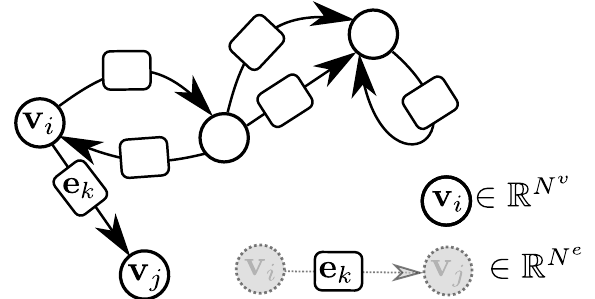
Figure 3. An attributed directed graph. Self-edges and multiple edges are allowed. Bi-directional edges are also